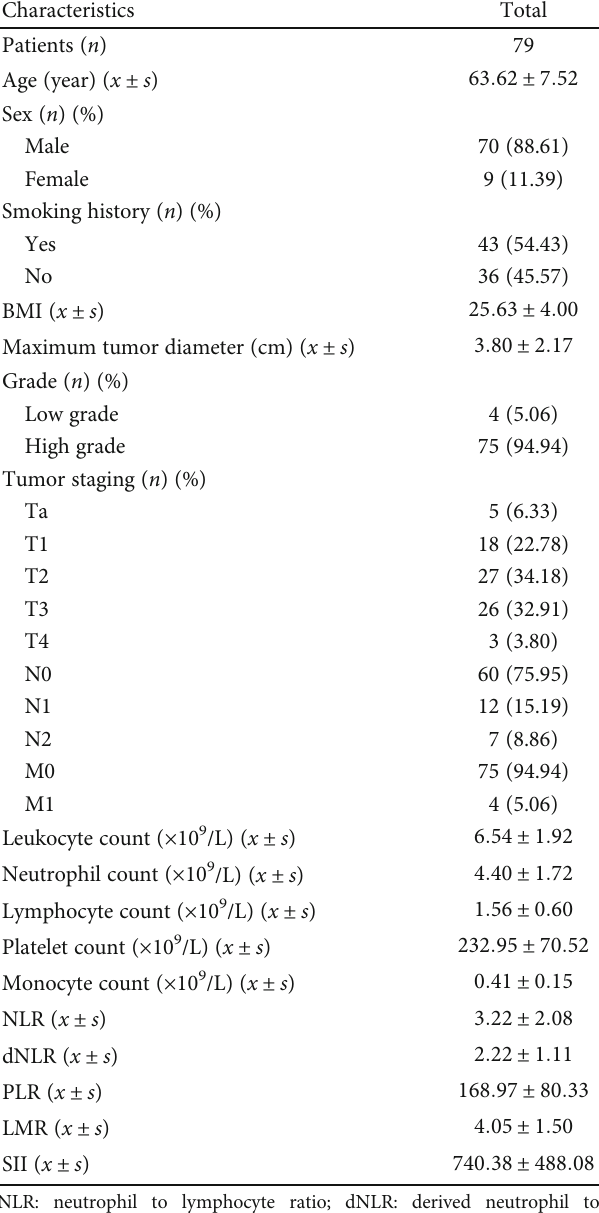
Table 1: Patients ’